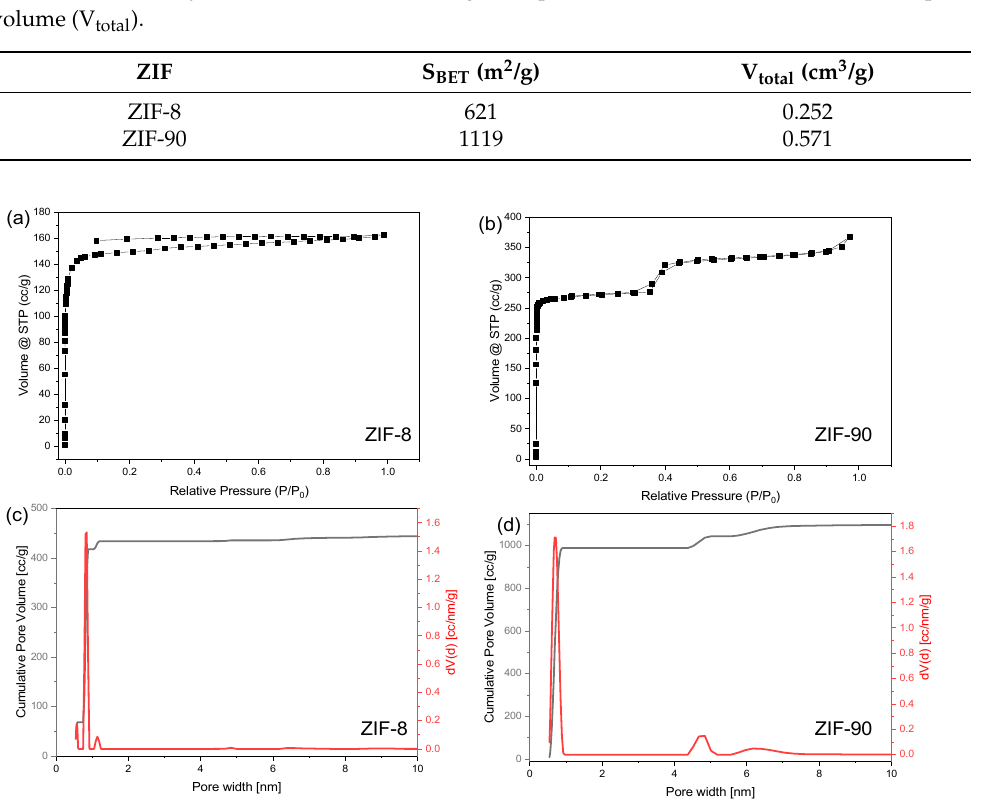
Figure 4. Nitrogen physisorption isotherms of activated ( a ) ZIF-8 and ( b ) ZIF-90 and pore size distribution of ( c ) ZIF-8 and ( d ) ZIF-90.